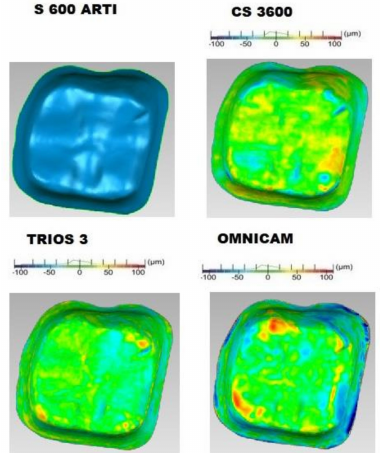
Figure 5. Comparison of the complete preparation in occlusal vision (OVA) rendering S600ARTI and three-dimensional (3D) comparison analysis for IOS without saliva in relation to the sample 1. Nominal histogram settings ± 25 microns and critical ± 100 microns.